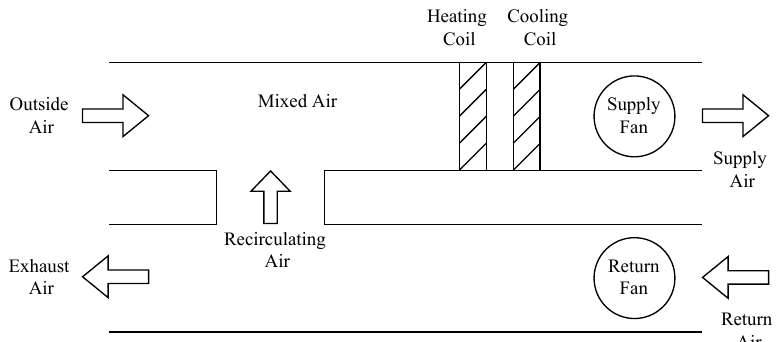
Figure 2. Schematic diagram of an air-handling